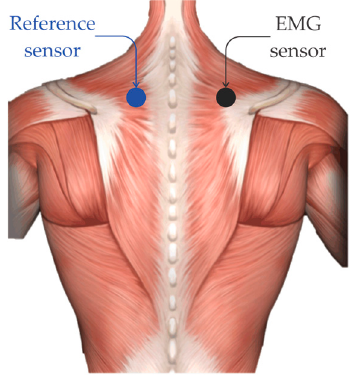
Figure 3. Localization of the EMG sensor in subjects.